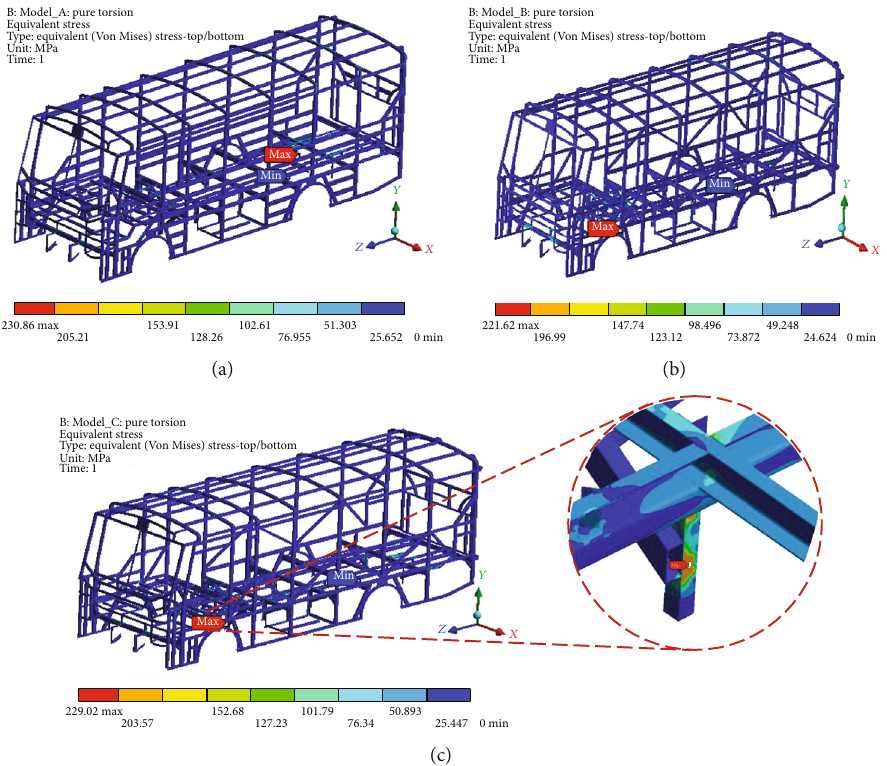
Figure 19: Equivalent stress in pure torsion: (a) baseline model; (b) model I (RD); (c) model II